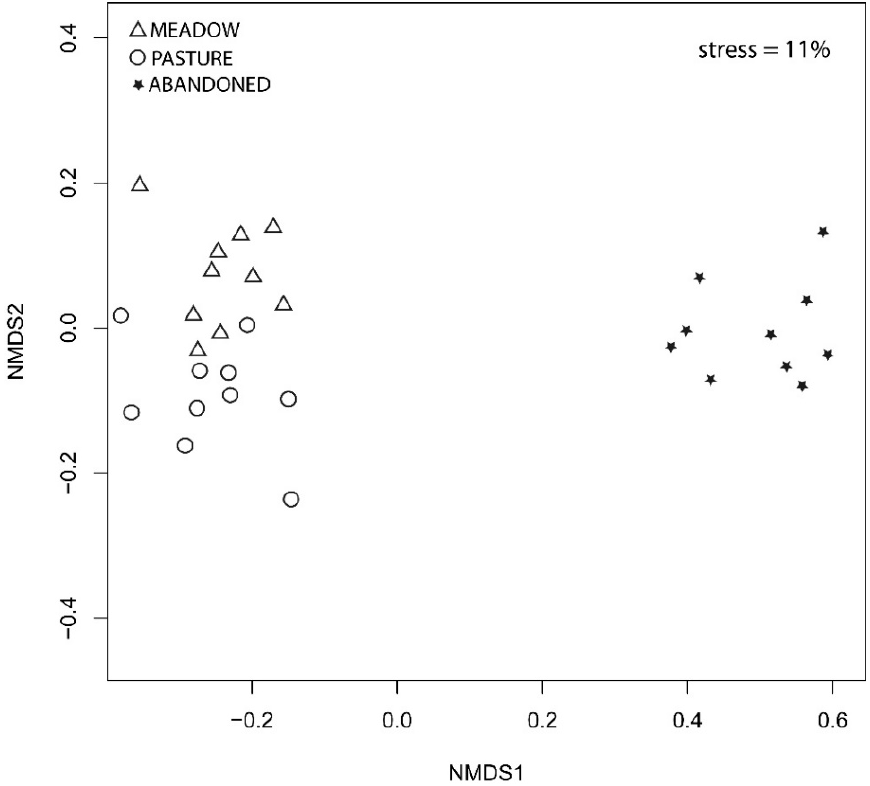
Figure 2. Two-dimensional solution of nonmetric multidimensional scaling of grassland plant communities based on the Bray–Curtis distance. Final stress value is displayed.